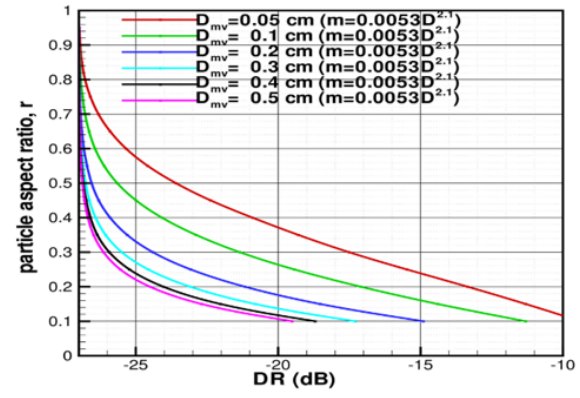
Figure 1. r -DR relations for di ff erent values of median volume particle size, D mv , assuming that the radar elevation angle α = 10 ◦ , transmission phase shift ϕ t = 90 ◦ , the standard deviation of particle wobbling σ θ = 20 ◦ , and m = 0.0053 D 2.1 mass-size relation ( m is in grams, D is in cm).